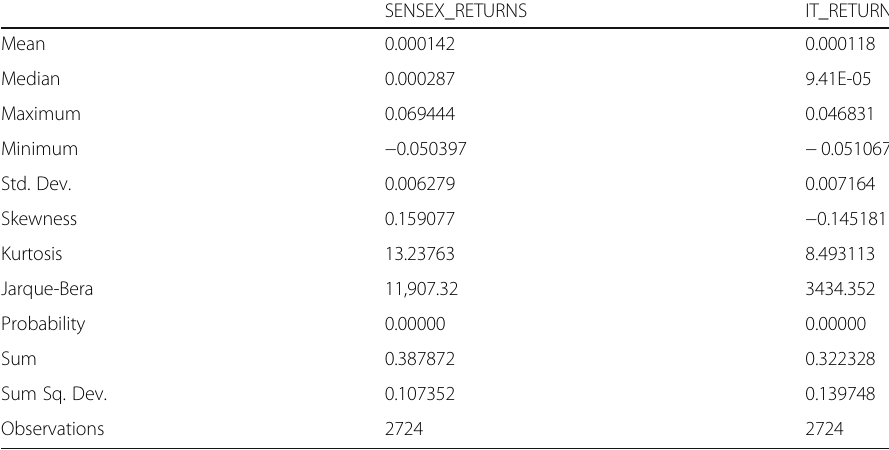
Table 1 Descriptive Statistics for S&P BSE Sensex and S&P BSE IT SENSEX_RETURNS IT_RETURNS Mean 0.000142